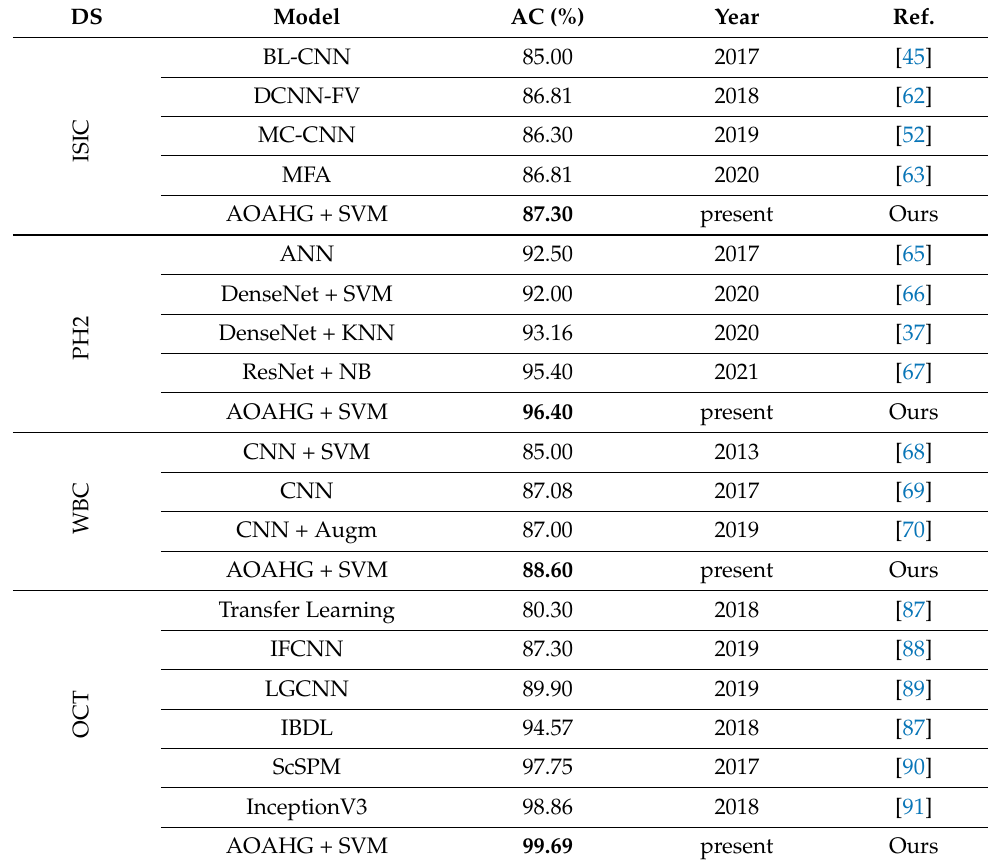
Table 4. Accuracy (AC) results of the developed method and other existing